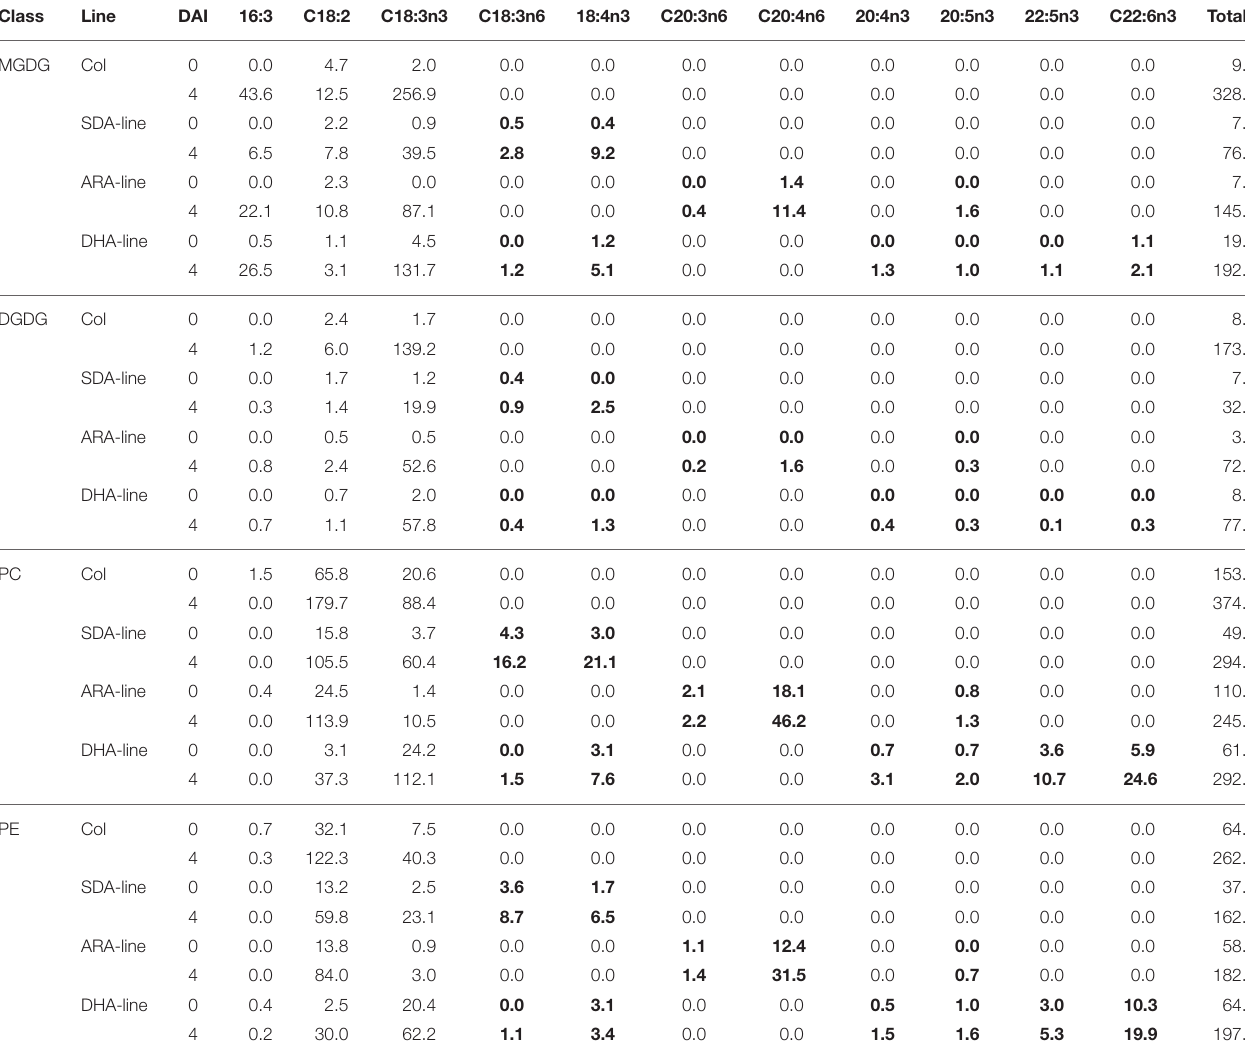
TABLE 6 | Fatty acid profiles of major membrane lipids during seedling development.